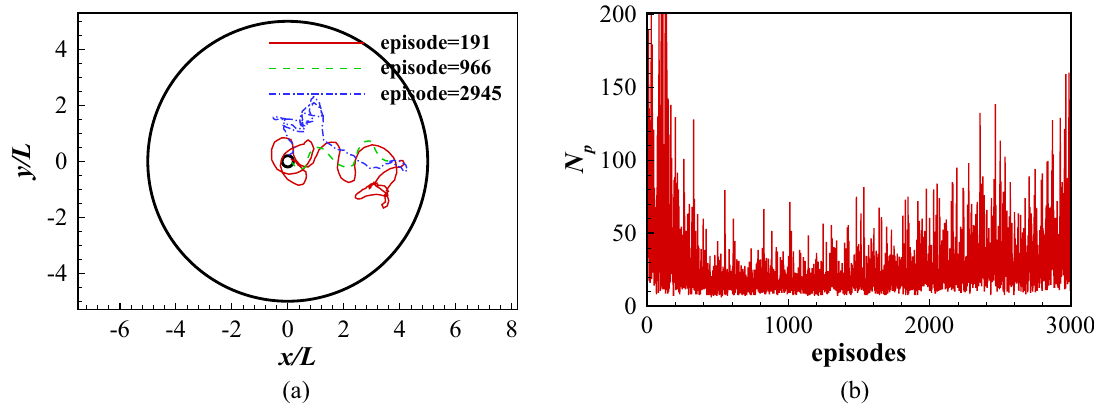
Figure 7. Point-to-point swimming with only the dynamics of the fish considered as the state: ( a ) the traces of the head for at different learning stages; and ( b ) the total number of periods the fish maintains in the swimming area for all episodes